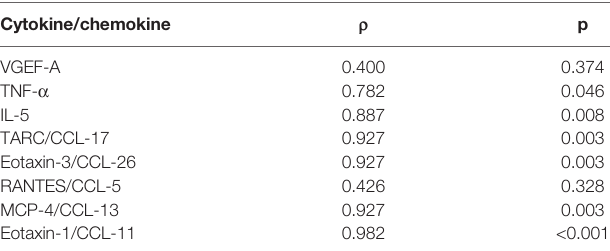
TABLE 1 | Correlation between cytokines/chemokines and ECW/TBW. Cytokine/chemokine r p